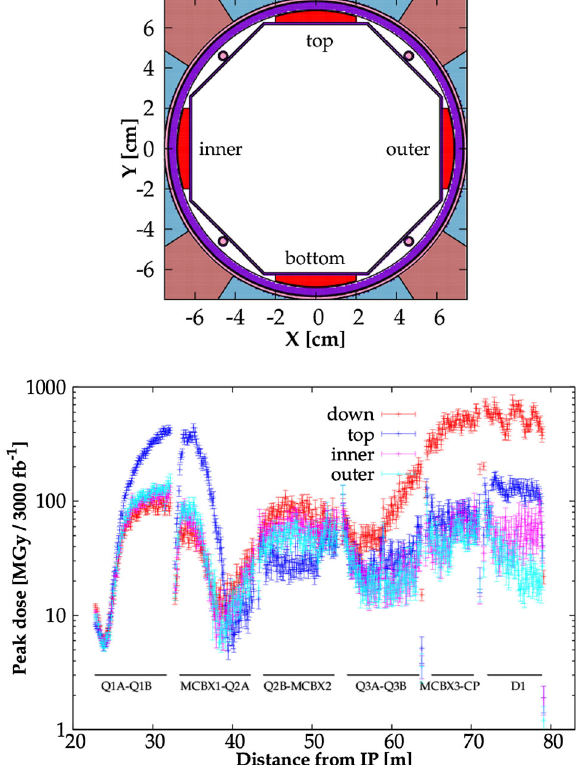
FIG. 8. Longitudinal peak power density profile on the inner coils of the IT magnets.